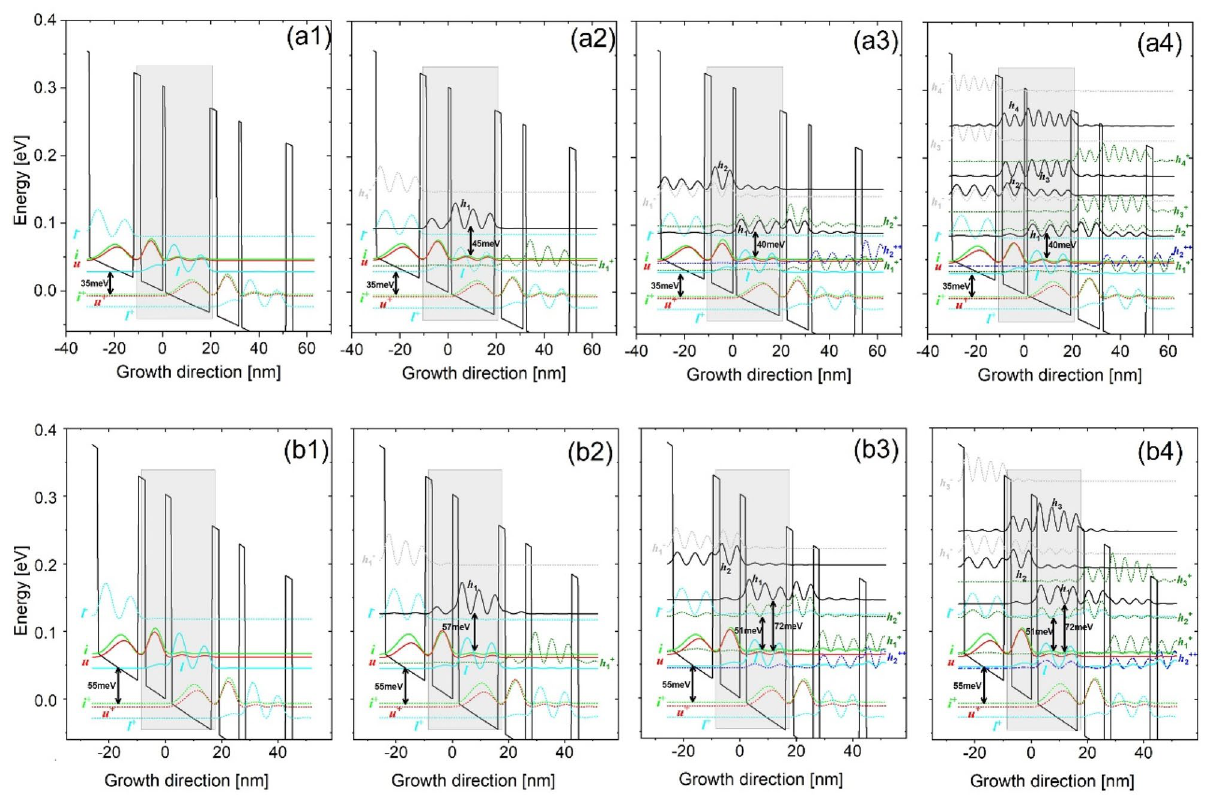
Figure 1. Conduction band profile of the investigated THz-QCLs employing the 2-well resonant- phonon scheme under an operating bias. The Wannier–Stark levels are indicated in three neighboring periods. Two depopulation energies are engineered; a 35 meV design (Al 0.3 Ga 0.7 As/GaAs, barriers/wells: 1.16 /18.4/ 2.85 /9.16 nm) ( a1 – a4 ) and 55 meV design (Al 0.3 Ga 0.7 As/GaAs, barriers/wells: 2.1 /14.3/ 2.5 /7.19 nm) ( b1 – b4 ). The underlined layer is doped by silicon at a sheet doping level of 3.2 × 10 10 and 5.4 × 10 10 cm −2 , respectively. The conduction band offset is assumed as 300 meV. The THz photon emission energy is 16 meV. The axial cut-off energies are tuned by controlling the exact number of quantum levels in the calculations. ( a1 , b1 ) contains only three relevant levels, ( i , u , l )-scale; ( a2 , b2 ) contains one more nonrelevant level along with the relevant levels, ( h 1 )-scale; ( a3 , b3 ) contains two more nonrelevant levels along with the relevant levels, ( h 1 , h 2 )-scale; ( a4 , b4 ) contains all the nonrelevant levels until the continuum area, ( full )-scale. Noted that the different energy scale can slightly effect on the relevant levels (i.e., injector alignment etc.), therefore the realignment at injector is performed for each